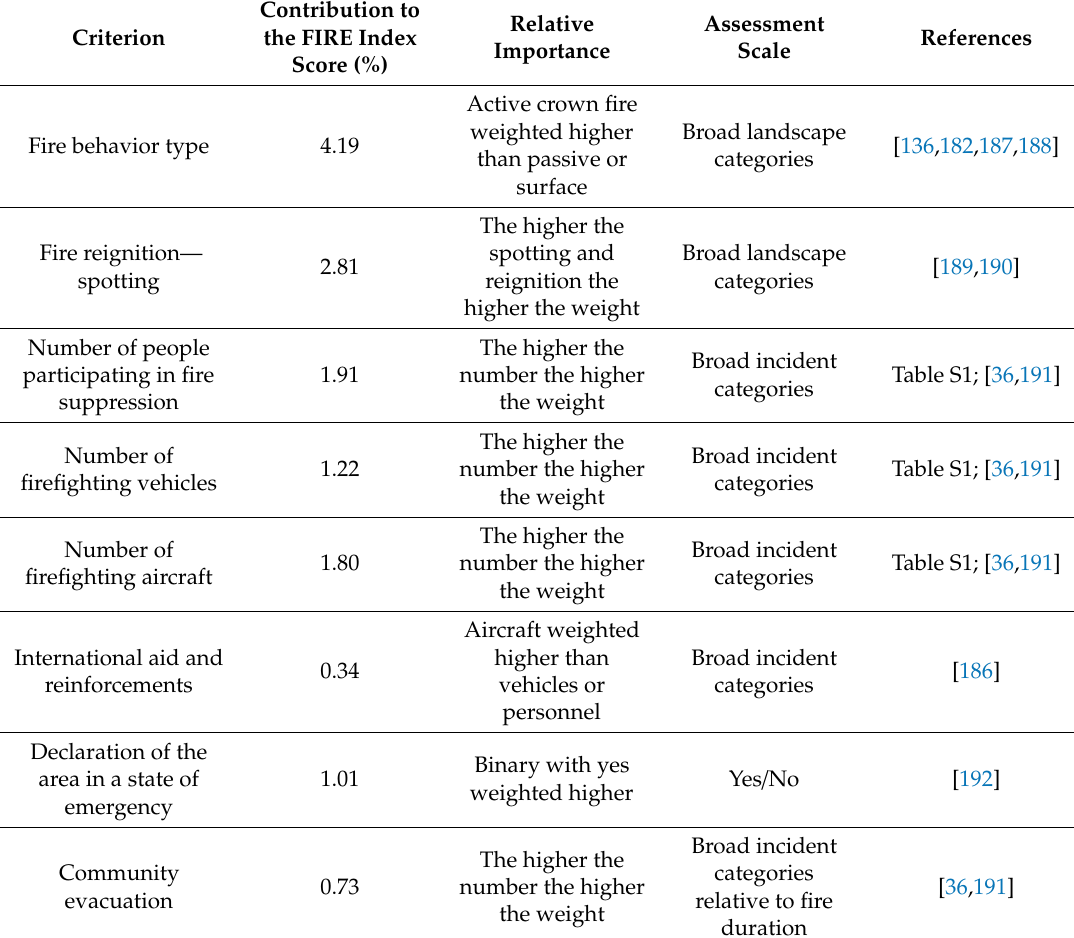
Table 4. Relative importance, assessment scale and relevant literature for each criterion for the firefighting and wildfire suppression fire e ff ects